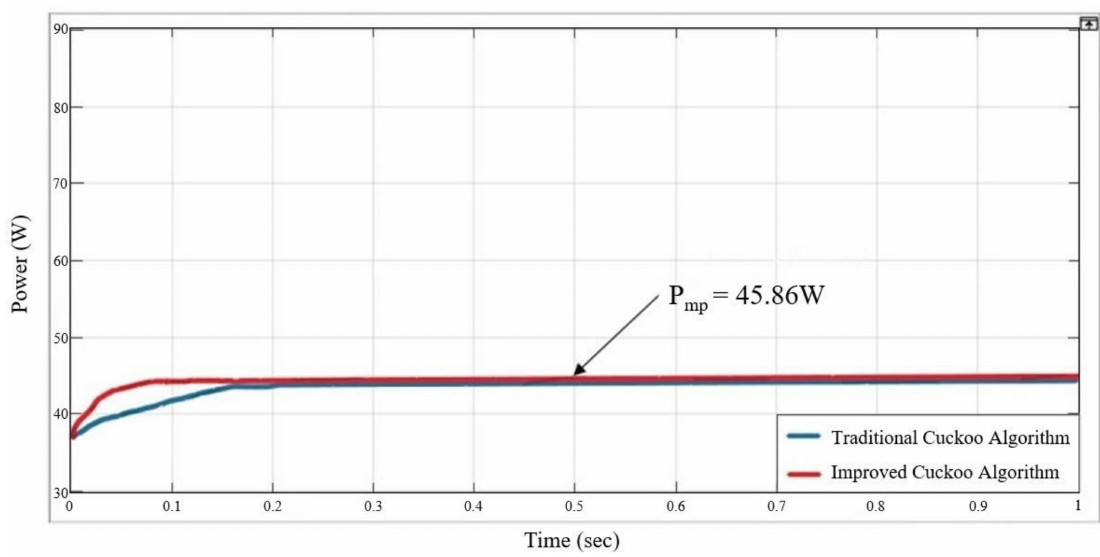
Figure 11. Simulation result of maximum power point tracking of traditional and improved cuckoo algorithm in Case